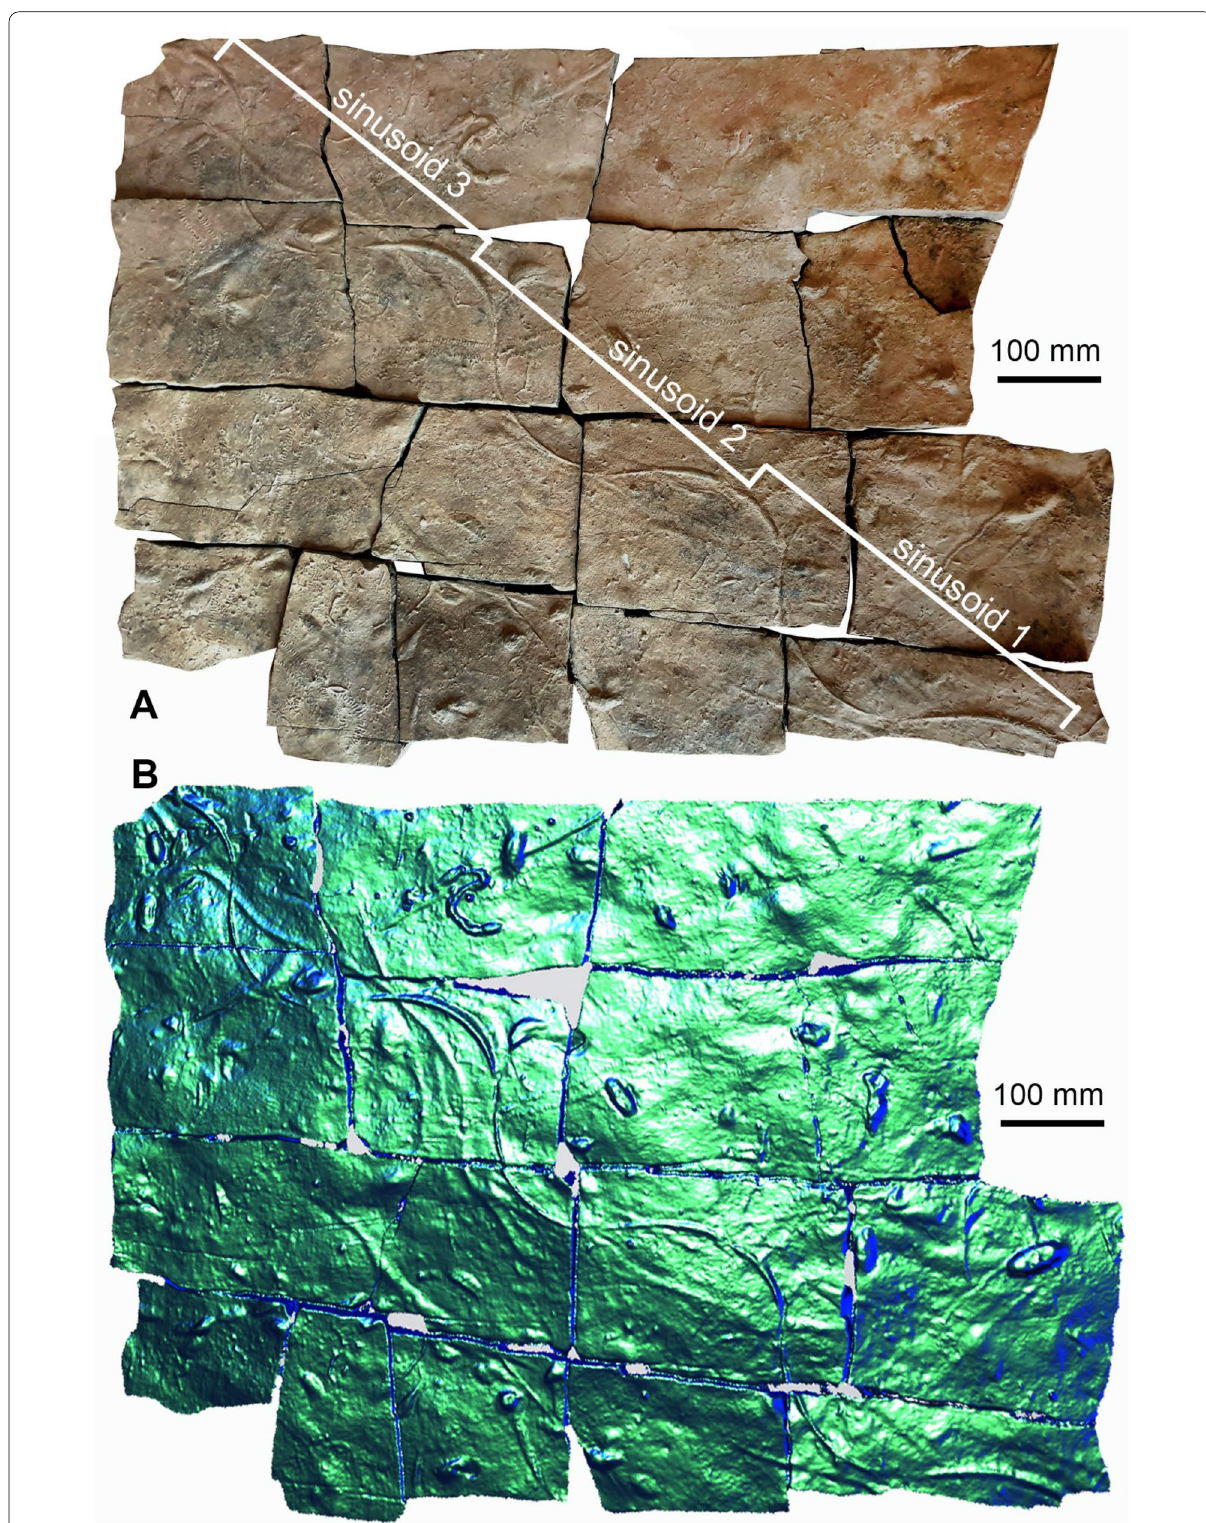
Fig. 5 Undichna britannica , PIMUZ A/I 5060, equivalent of the Hangenberg sandstone, latest Devonian, El Khraouia, near Merzouga and Taouz. A Photo taken under shallow white light with the main light source on the bottom left. B 3D scan with Artec Eva. The tracks of the fins are well discernible, particularly the impression of the caudal fin is sharp, overlaying the